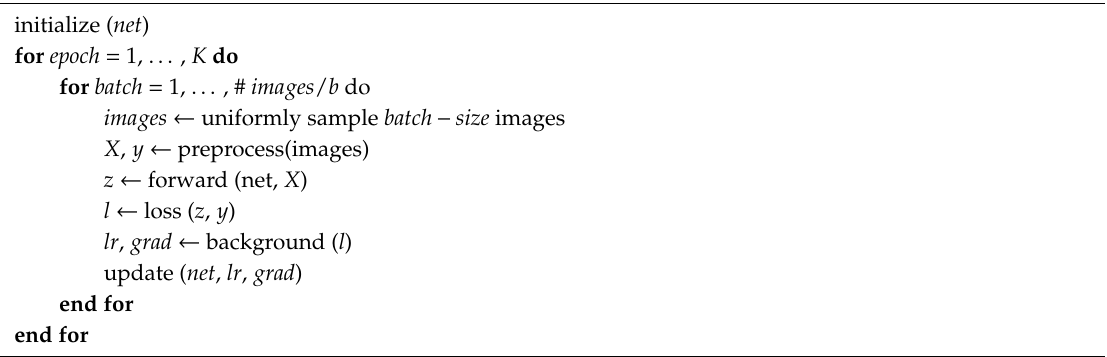
Algorithm 1 Train a neural network with the minibatch Adam optimization